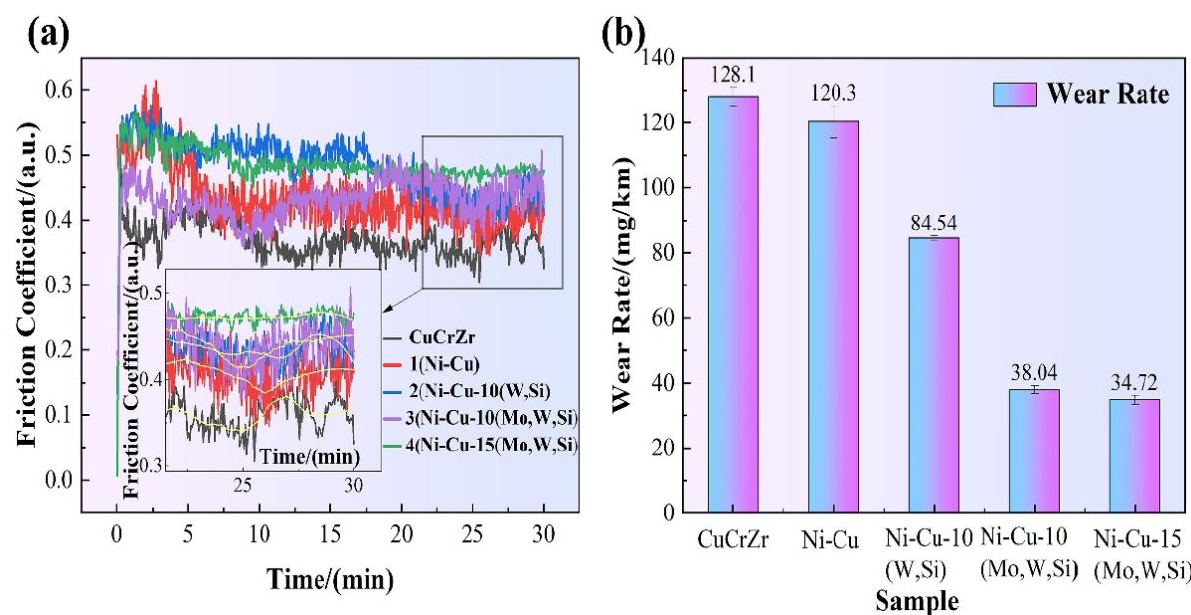
Figure 9. ( a ) Friction coefficients of the substrate and coatings, and ( b ) wear rates of the substrates and coatings.